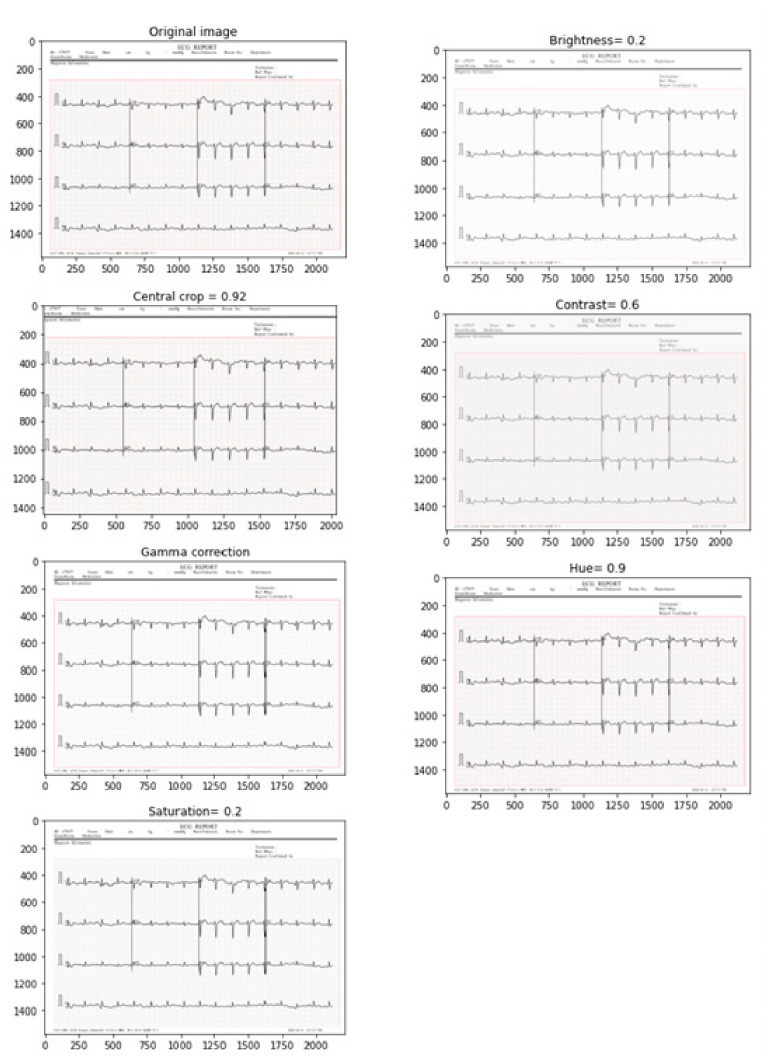
Figure 5. ECG images modifications after the data augmentation process.